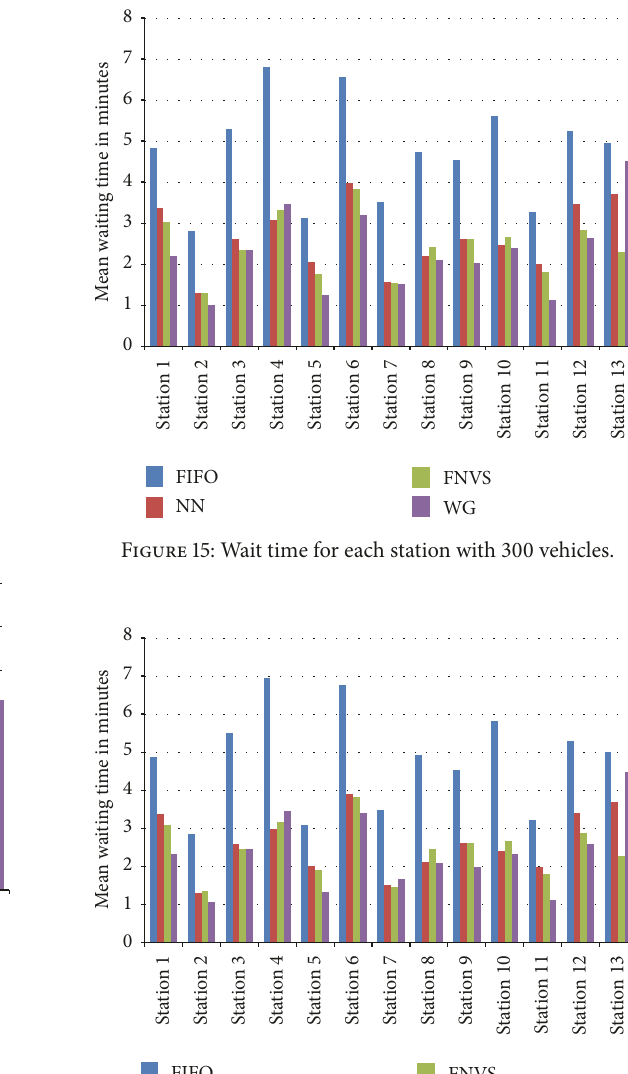
Figure 14: Wait time for each station with 200 vehicles.